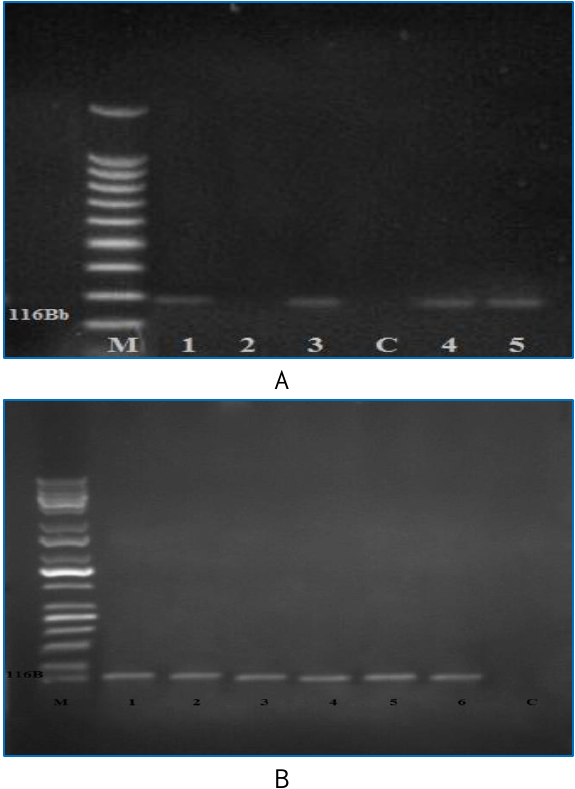
Figure, 2: Electrophoresis pattern of PCR product of SRY gene with 116 bp size of in vitro produced local goat embryos, PCR amplification product in: A- columns 1, 3, 4, and 5 indicated the male embryos while the in column 2 indicated the female embryo. In B- all column indicated the male embryo. Amplified DNA stained by red gel in the 2% agarose